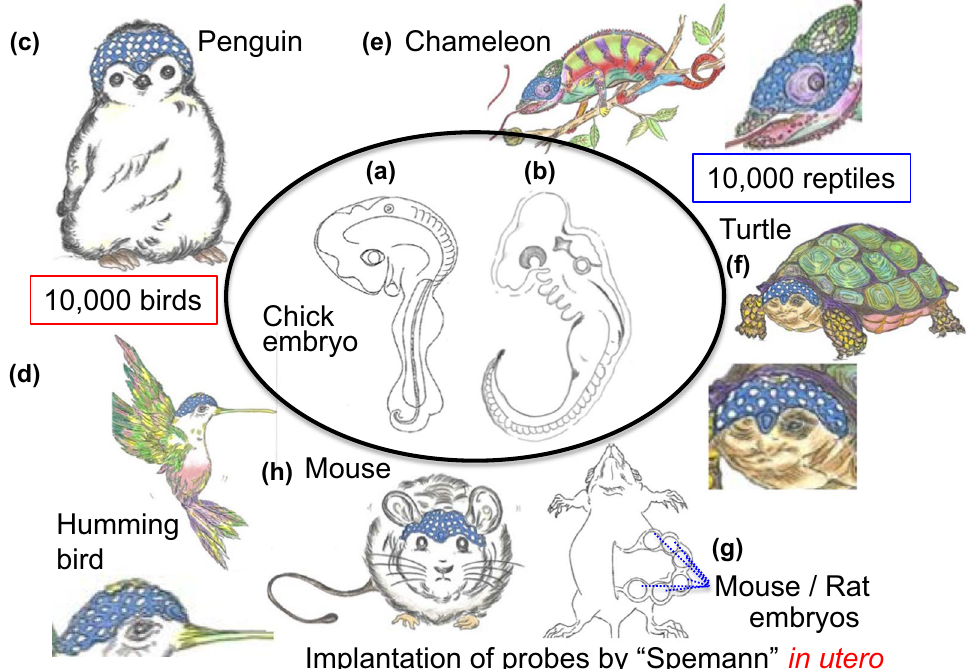
Fig. 7 Application to amniotic embryos. a Stage-18 chick embryos (opposite side view of Fig. 5A(b)) utilized for bead inoculation in this study. ( b ) Sketches of Haeckel’s pharyngula-stage chick embryo (Richardson 1995). Illustrations of ( c ) a penguin, ( d ) hummingbird, ( e ) chameleon, and ( f ) turtle. ( g ) The abdomen of small mammals (e.g., mice and rats) can be robotically opened, and then probes can be inoculated into the head region of embryos in utero by “Spemann”. ( h ) An illustration of a mouse whose brain has multiple probes. All animals ( c – f , h ) are wearing a blue helmet representing a NIR transmitter, as in Fig. 1(b) and Fig.